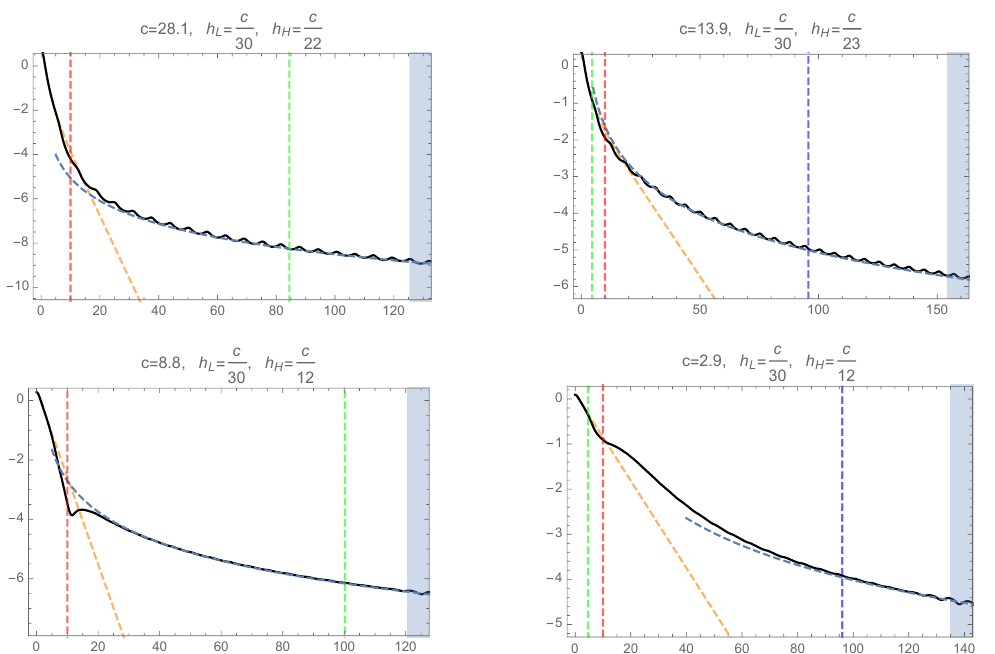
Figure 13 . These plots show a variety of parameter choices where the behavior of Virasoro blocks on the timescale e S (green vertical line), and even e e S (blue vertical line), are visible. Yellow lines indicate semiclassical behavior, while the light blue (cid:12)t corresponds to t (cid:0) 3 2 . Recall S = (cid:25) 2 24 h H 2 (cid:25)T H = 1, so some plots have relatively large c and small T H , while others have order one c (cid:0) q T H but small c . In all cases we see that the t (cid:0) 3 2 late-time decay persists on these exponentially long timescales. These plots all display vacuum blocks, but we have found similar behavior with h >